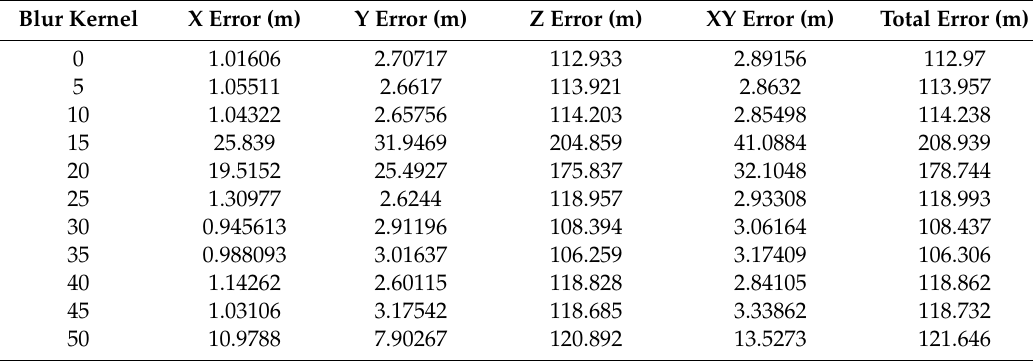
Table 3. Average camera location error. X—Easting. Y—Northing.